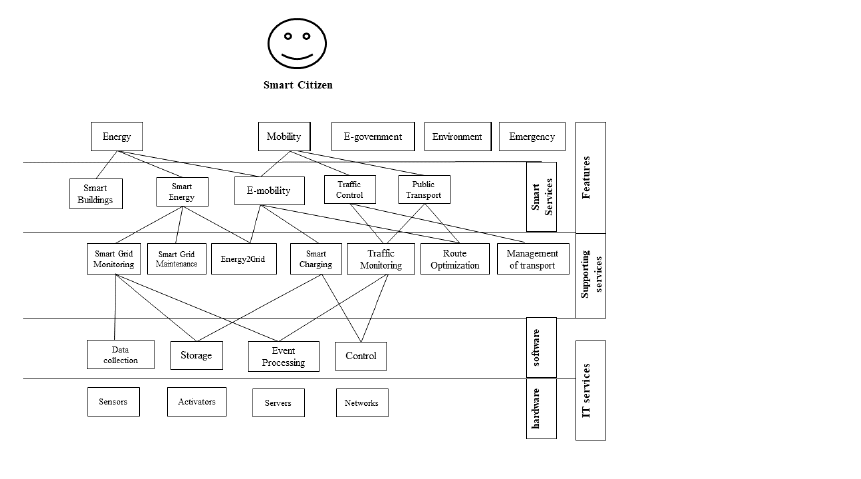
Figure 4. The structure of smart city layers